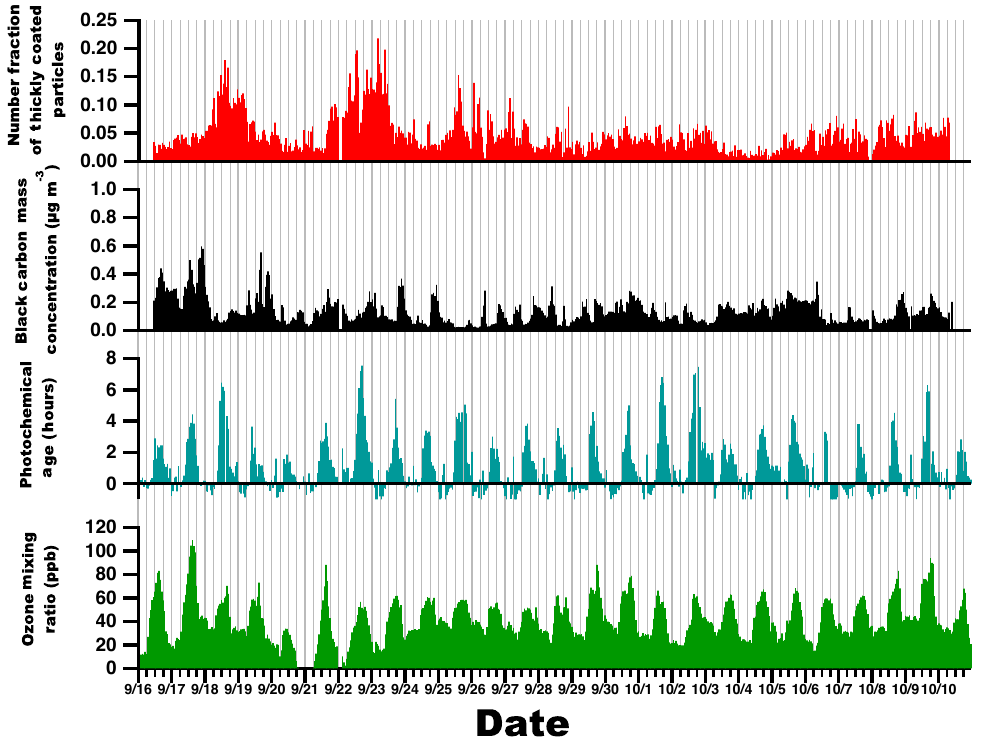
Figure 5. Overview of hourly mean results for the Redlands campaign including fraction of rBC that is thickly coated ( f , estimated using the lag-time method), rBC mass concentration (µgm − 3 ), and ozone mixing ratio (ppb). Photochemical age (PCA) was computed using measurements of NO x to NO y at Rubidoux, California, roughly 30km to the southwest of